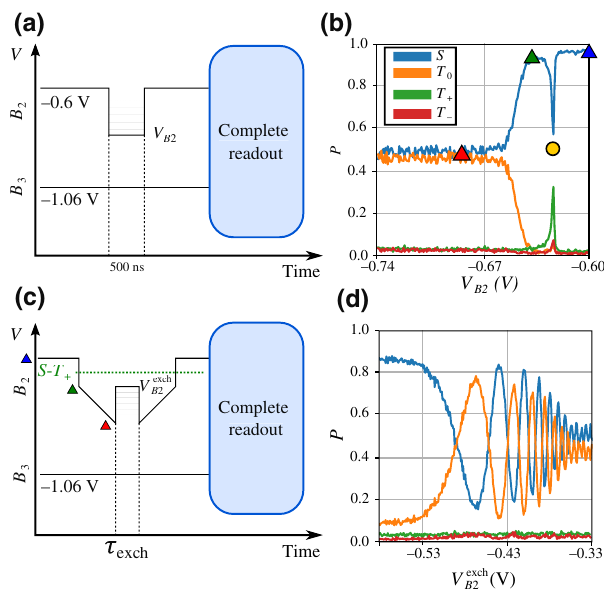
FIG. 4. Spin-state operations observed via the complete readout procedure. (a) Pulse sequence performed to obtain (b). The system is initialized in a singlet state at a large value of t c ( V B 2 = − 0.6 V) in the (1,1) charge-state region ( V B 3 = − 1.06 V), the interdot gate B 2 is pulsed during 500 at a variable amplitude V B 2 . A complete readout procedure is then performed, the output is classified using the methodology described in Fig. 3. (b) Singlet transformation with respect to the interdot tunnel coupling. (c) Pulse sequence used to perform S - T 0 exchange oscillations. The initial S spin state is conserved via a nona- diabatic pulse across the S - T + avoided crossing from the blue triangle position to the green triangle one. It is then transformed adiabatically to |↑↓(cid:4) or |↓↑(cid:4) (depending on the sign of (cid:3) B z ) via a ramp from the green triangle to the red one. From there, the exchange coupling J is increased via an interdot tunnel coupling during a fixed time τ exch = 1.6. During this time the pulse V exch B 2 system evolves at a frequency J between |↑↓(cid:4) and |↓↑(cid:4) , and finally the mirrored sequence is applied to stop the oscillations and map the two states to S and T 0 . (d) Spin-state probability at the end of the exchange pulse sequence. As expected the S and T 0 probability are oscillating out of phase. We observe a negligi- ble leakage to the T + and T − state proving the efficiency of the procedure to perform a SWAP